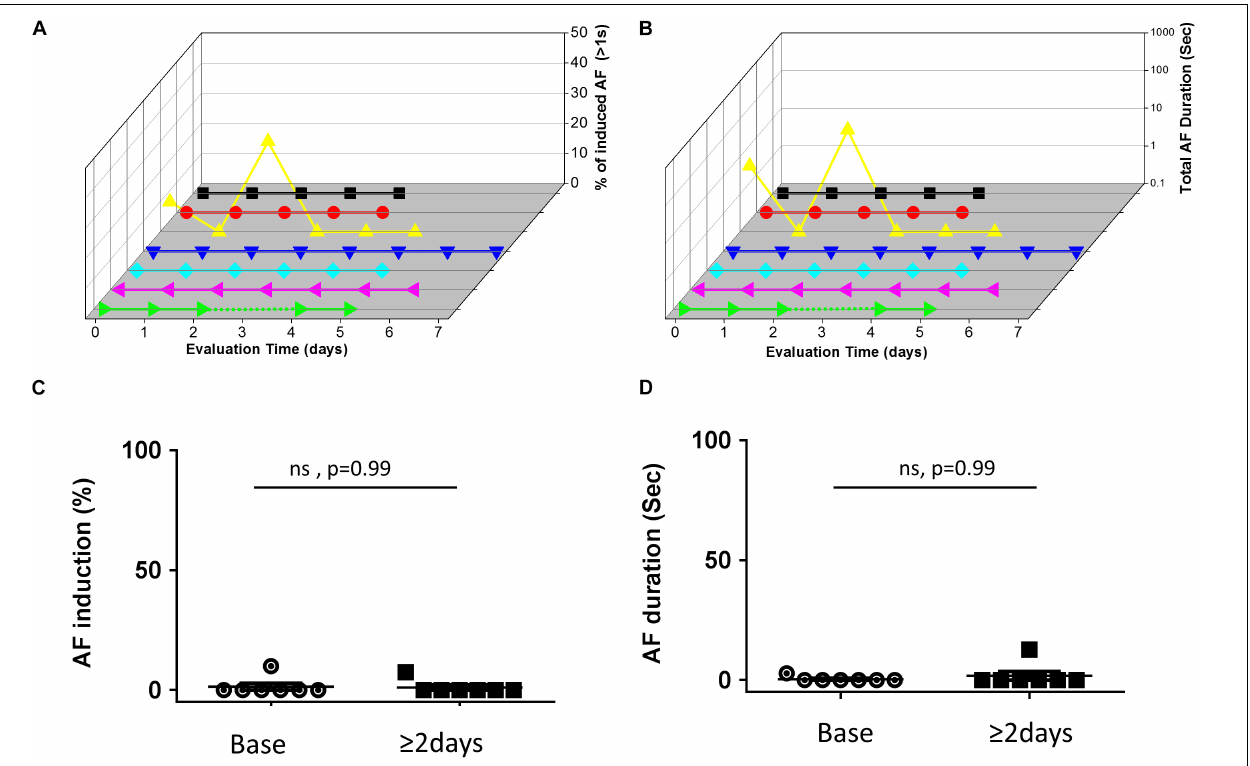
FIGURE 3 | Absence of AF substrate augmentation in mice exposed to RAP. (A,B) Analysis of AF induction and AF duration in seven mice in which RAP could be maintained for up to 7 consecutive days. 3D plots of daily AF evaluation as in Figure 2 . Note that only one animal demonstrated AF episodes and no clear effect of the RAP could be detected. (C,D) Summary analysis comparing the AF substrate before and after 48 h of continuous RAP at CL = 50 ms. Note absence of AF substrate augmentation following RAP in